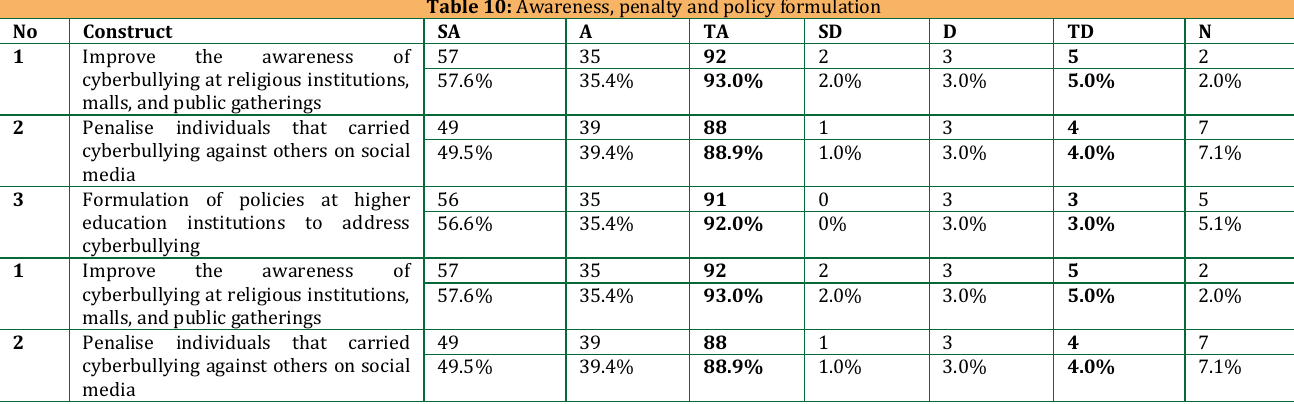
Table 10: Awareness, penalty and policy formulation